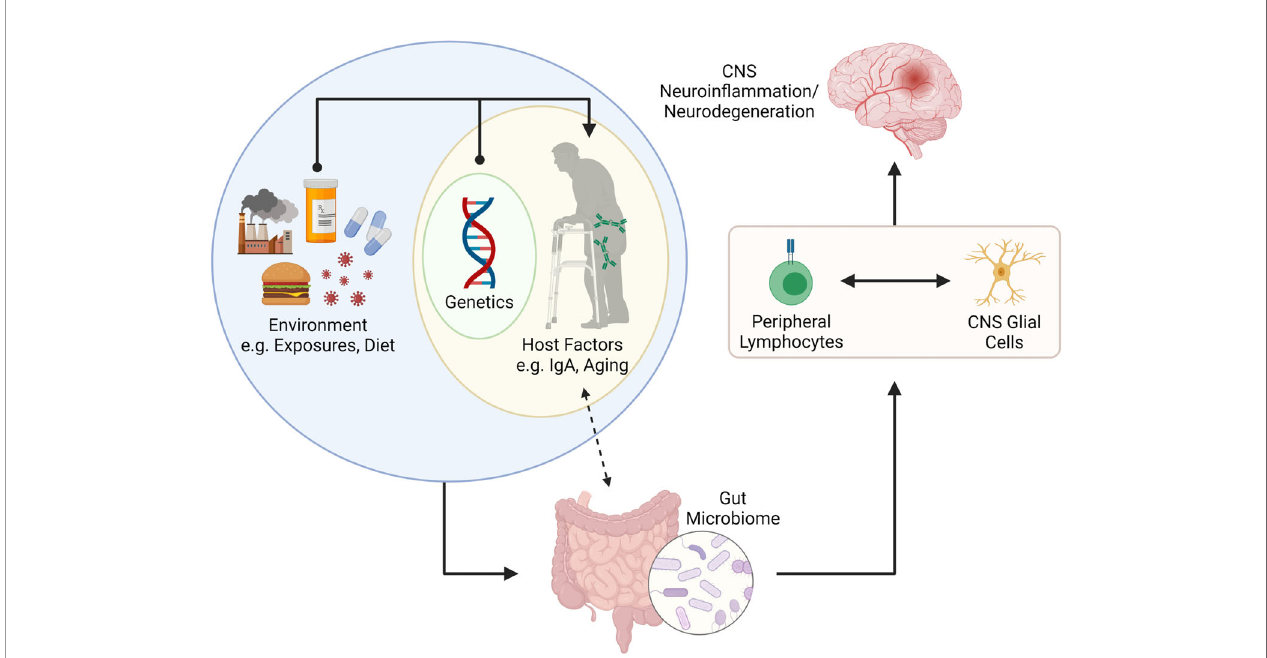
FIGURE 2 | Putative connection between the gut microbiome and CNS neuroin fl ammation and neurodegeneration. The gut microbiome is shaped by internal (e.g., genetics and other host factors such as mucosal IgA and age) and external factors (e.g., environmental exposures, infections, diet, etc.). Recent literature has suggested that IgA plays a key role in determining the microbes that reside in the gut, but that IgA levels can also be in fl uenced by colonizing microbiota. The gut microbiome is important for programming of peripheral lymphocytes but can also impact the phenotype and function of CNS resident glial cells ( via metabolites such as SCFAs. The activation (or modulation) of lymphocytes and glial cells can lead to neuroin fl ammation or neurodegenerative disorders in the CNS. Figure made using